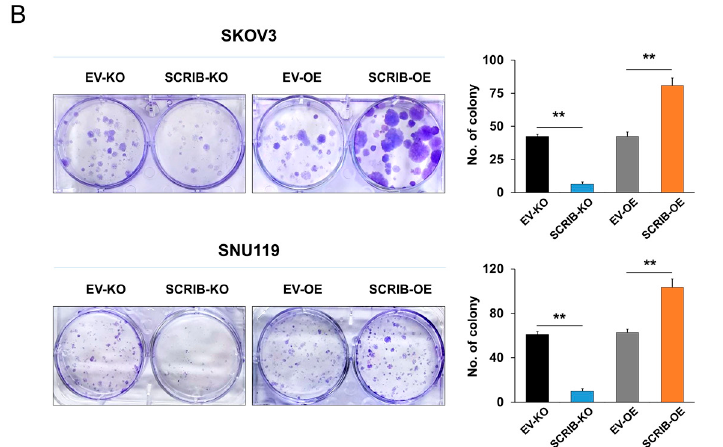
Figure 5. The effect of SCRIB on the proliferation of ovarian carcinoma cells. ( A ) SKOV3 and SNU119 cells were transfected with empty vector, vector for knockout of SCRIB , or SCRIB overexpression vector and performed CCK8 proliferation assay by growing 3000 cells in a 96-well plate for 24, 48, and 72 h. Knockout or overexpression of SCRIB in both SKOV3 and SNU119 cells were verified via western blot bands for SCRIB and actin. ( B ) The colony-forming assay in SKOV3 and SNU119 cells was performed by seeding 1000 cells per well in a 6-well plate for two weeks. * p < 0.05, ** p < 0.001.